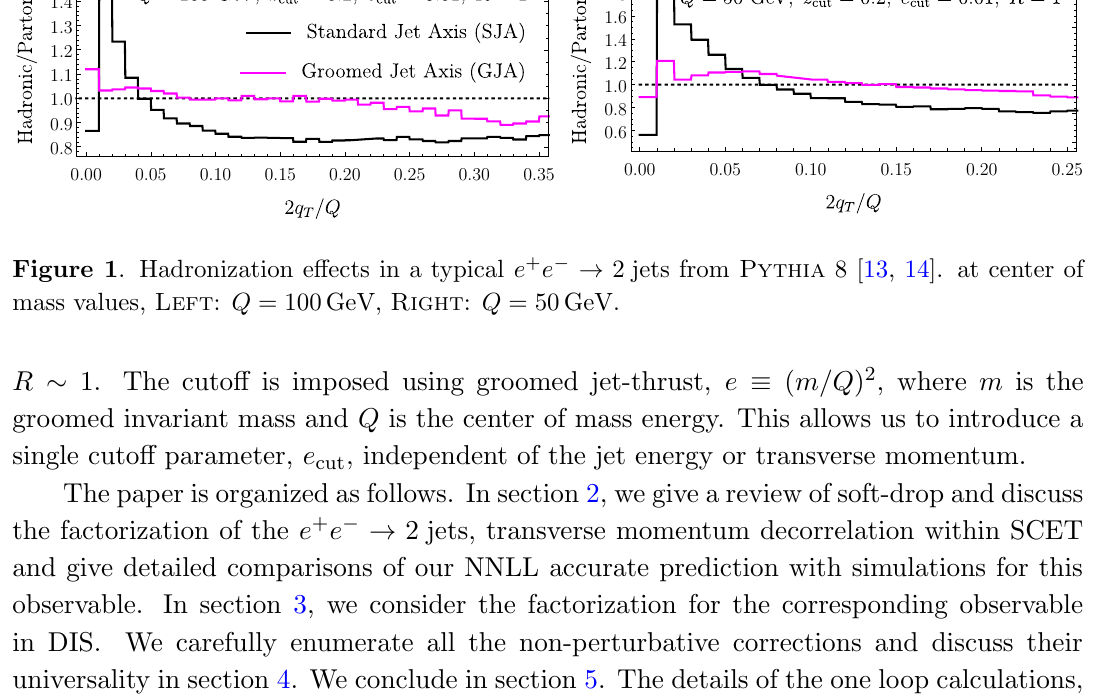
2 jets from Pythia 8 [13, 14]. at center of − →